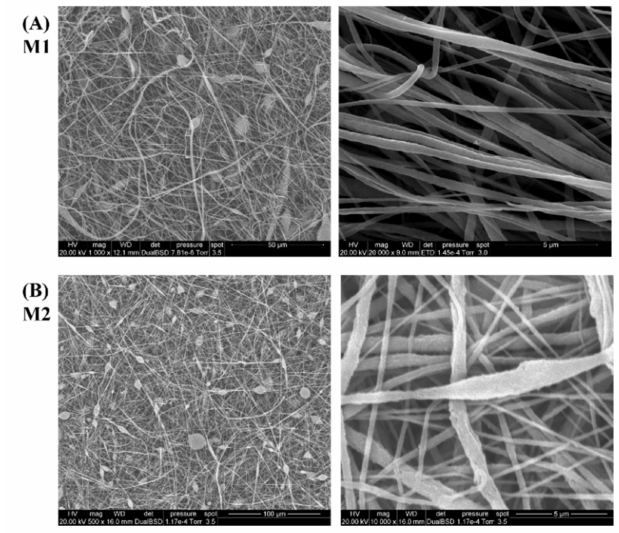
Figure 3. SEM images of PVDF nanofibrous membrane at two magnifications: ( A ) M1 (using DMF/ACE (2/1)) and ( B ) M2 (using DMF/THF